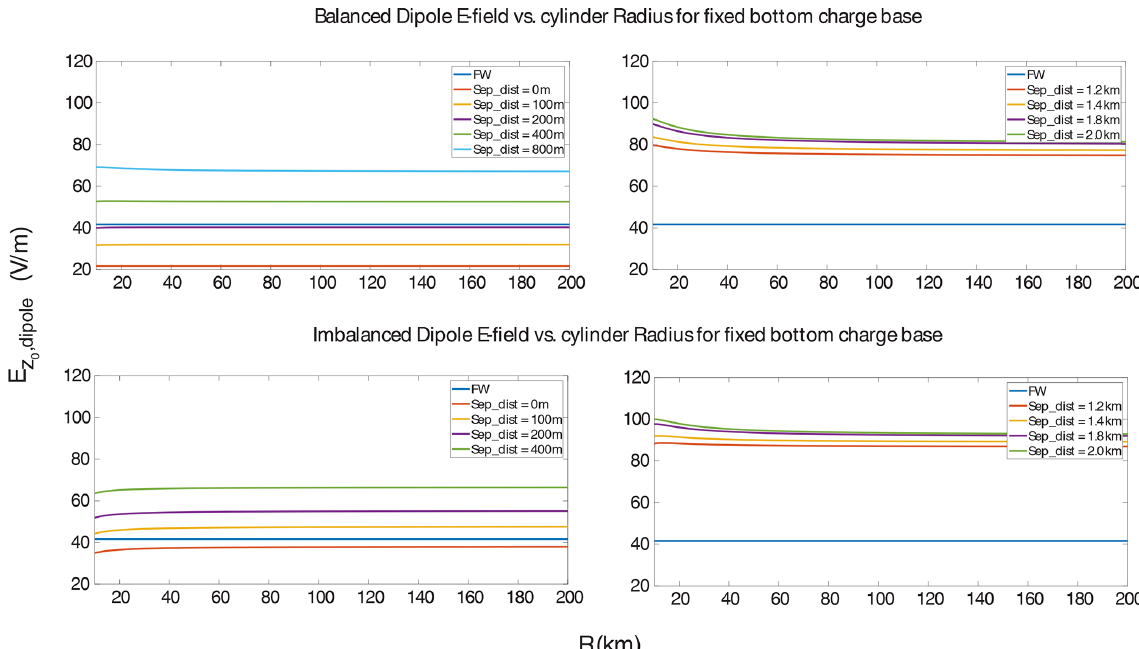
Figure 10. Dipole electric field strength at ground level ( E z ) as a function of the cylinder radius R , with the bottom cylinder at 2km 0 , dipole fixed central height within the dust layer. The separation distance (Sep_dist) between the upper and bottom charged layer increases as the upper cylinder moves towards the top of the dust layer, for both cases of balanced and imbalanced